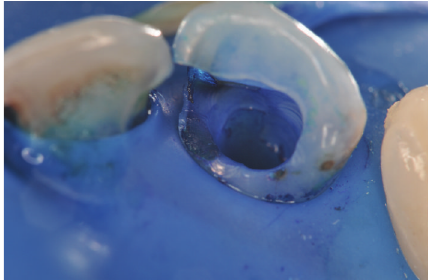
Figure 7: Dentin tissue stained with photosensitizing agent. It is important to aspirate the contents prior to light irradiation.